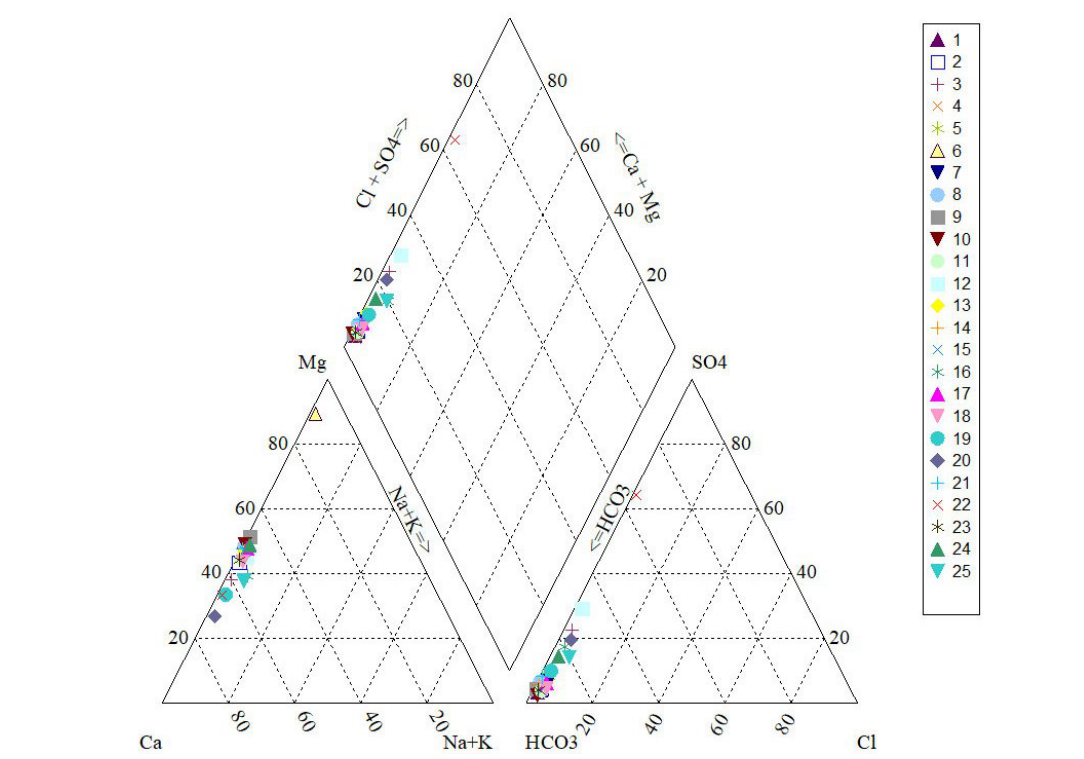
Figure 4. The trilinear piper diagram for groundwater samples collected from the studied dolomite aquifer between 2008 and